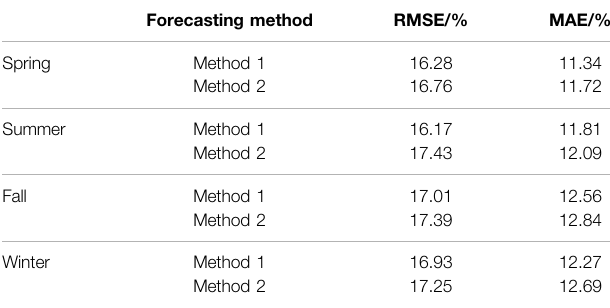
TABLE 5 | Accuracy comparison of prediction